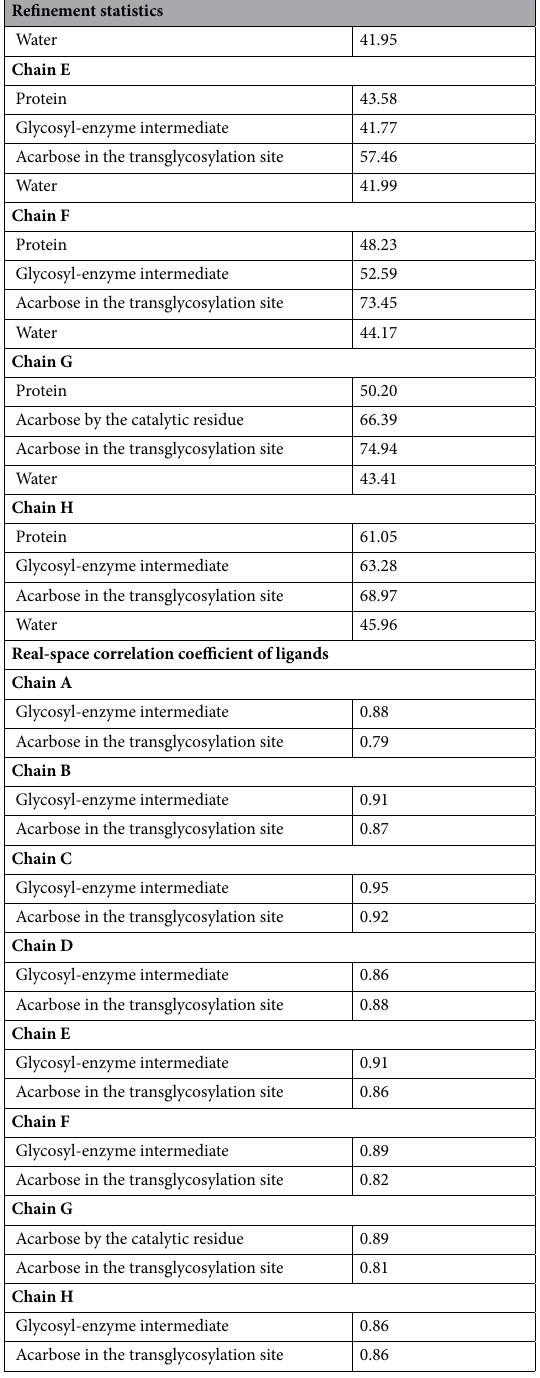
Table 2. Data collection and refinement statistics for WT Sa AM. Statistics for the highest-resolution shell are given in